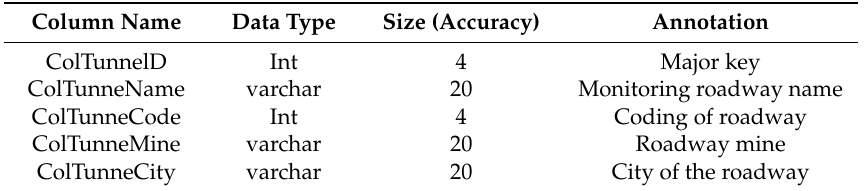
Table 6. ColTunnel dimension table properties.